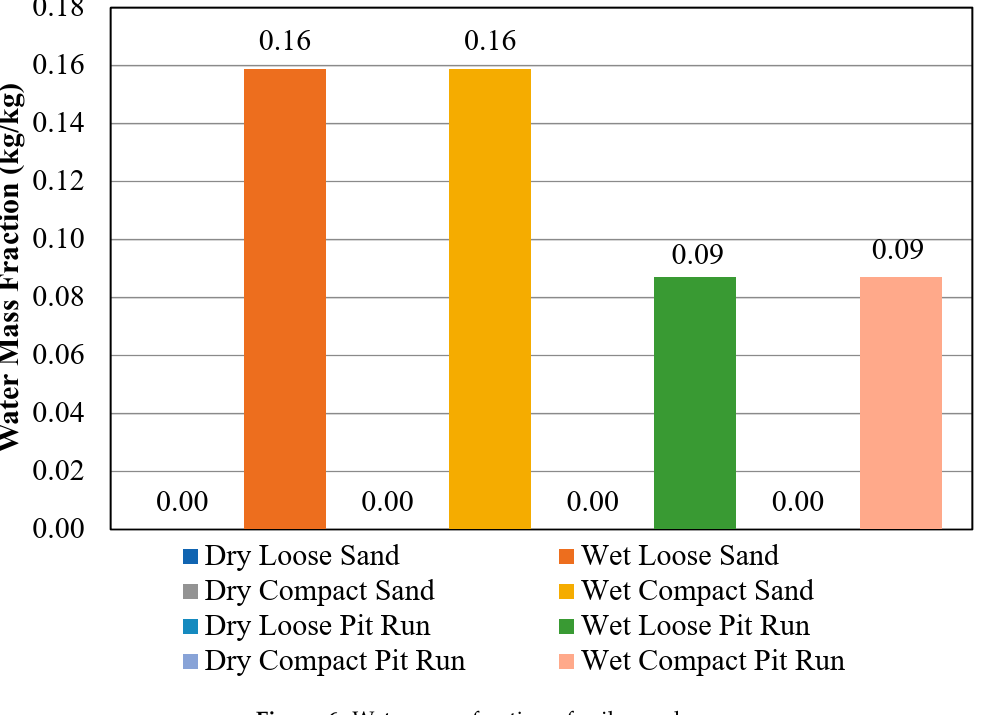
Figure 6. Water mass fraction of soil samples.